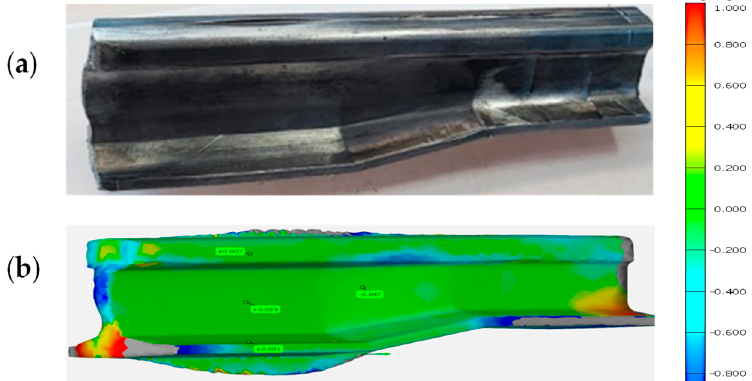
made of Pb to the nominal CAD model, which is shown in Figure 11.